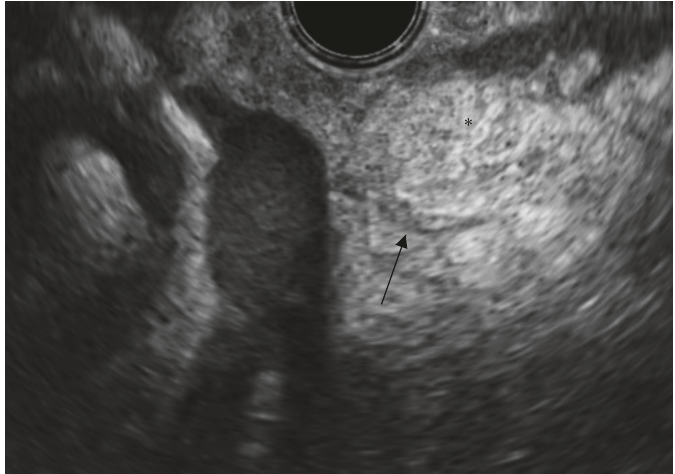
Figure 4: EUS image of the hyperechoic mesenteric soft tissue mass (black asterisk) with a hypoechoic, ductal structure (black arrow)